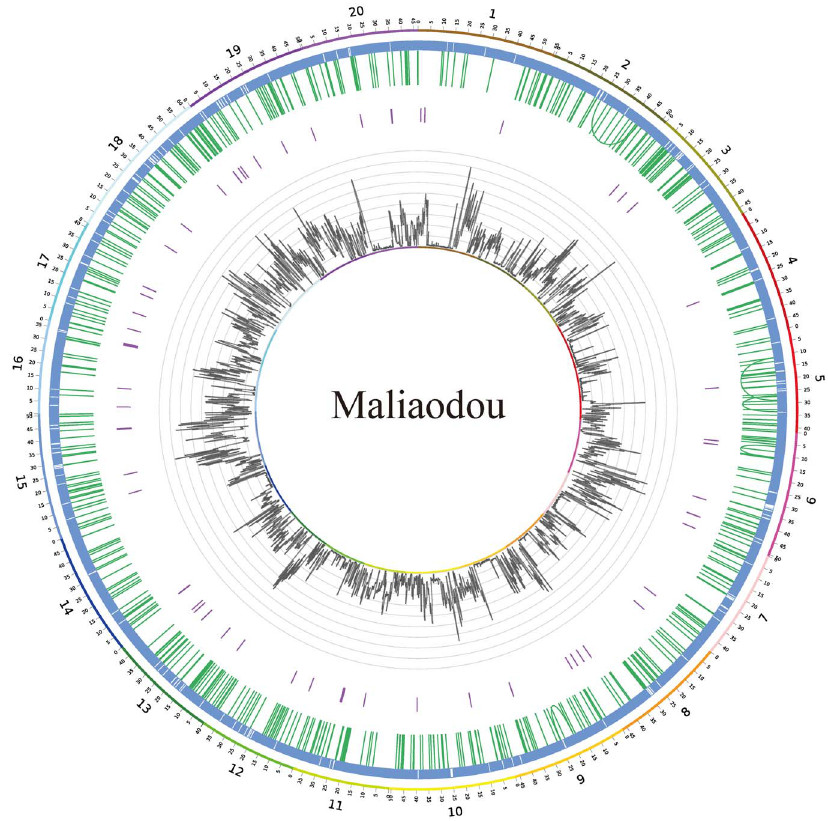
Figure 2. Genomic variations between the semi-wild genome Maliaodou and the reference genome Williams 82. Circles from outside: 20 chromosomes labeled with different colors; in the blue bars, each white vertical line presents a . 10 kb un-mapped region in the reference genome; green and purple vertical lines present the intra-chromosomal translocations and inversion events, respectively. Distribution of the SNP density of the Maliaodou is labeled with grey lines.